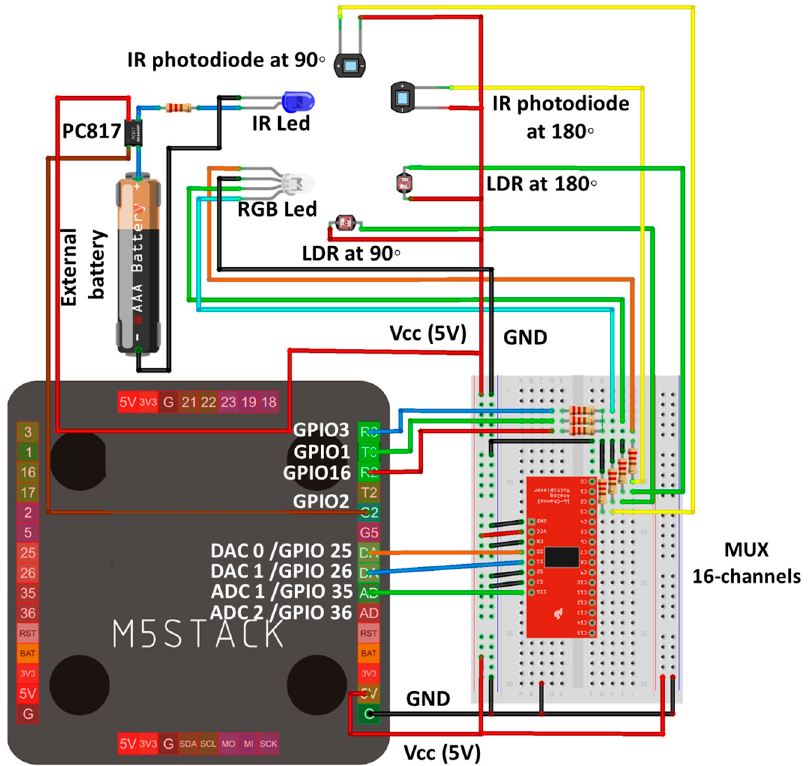
Figure 2. Electric scheme of the prototype.